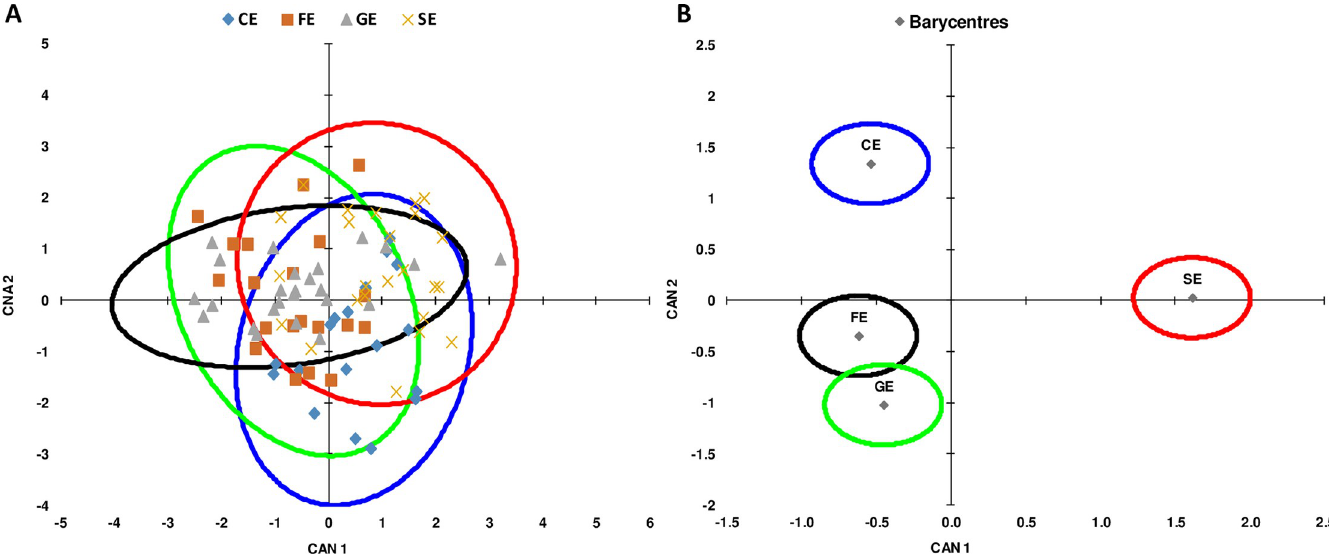
Fig 4. Canonical representation of the morphometric traits. (A) Association with individuals by ecotype. Canonical representation of the barycenter of four ecotypes (B).